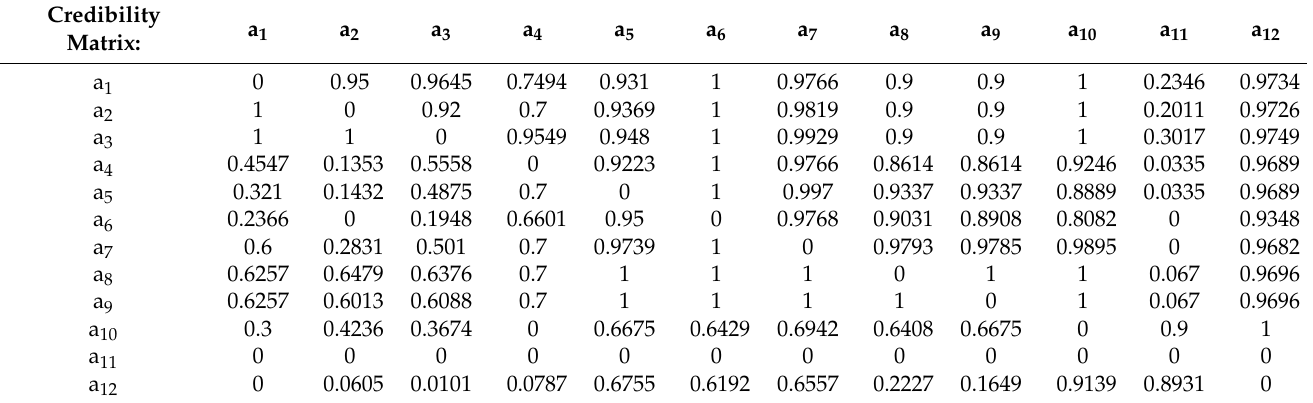
Table A8. Credibility matrix values